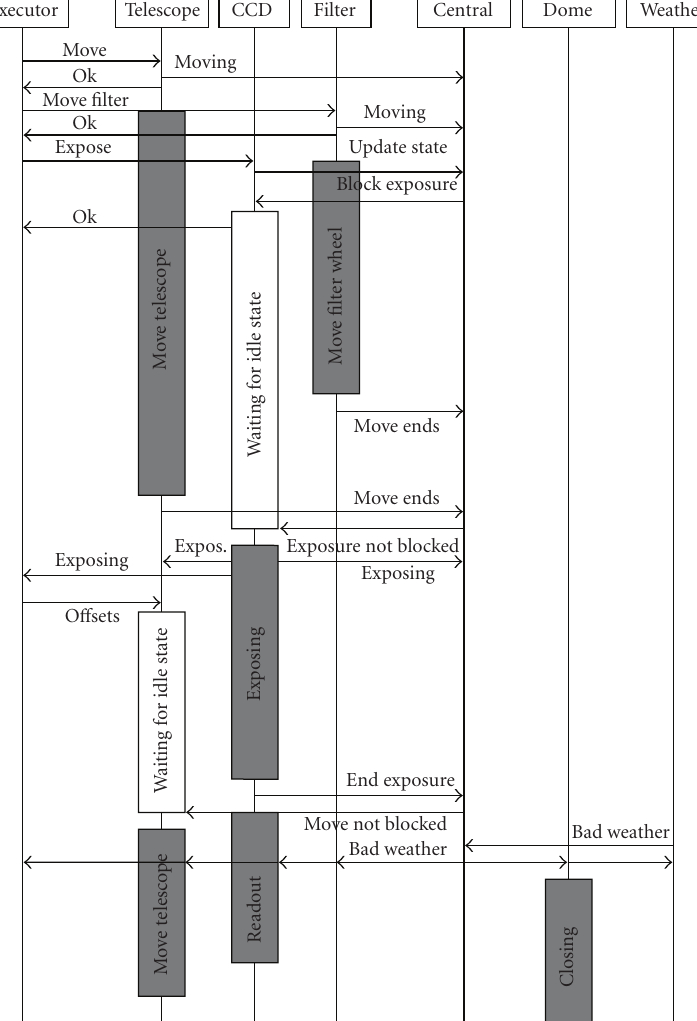
instrument setup and astronomer preferences, he/she picks a queue and executes its observation. After the target is finished, a new target is picked from the queue, or the queue is changed by the